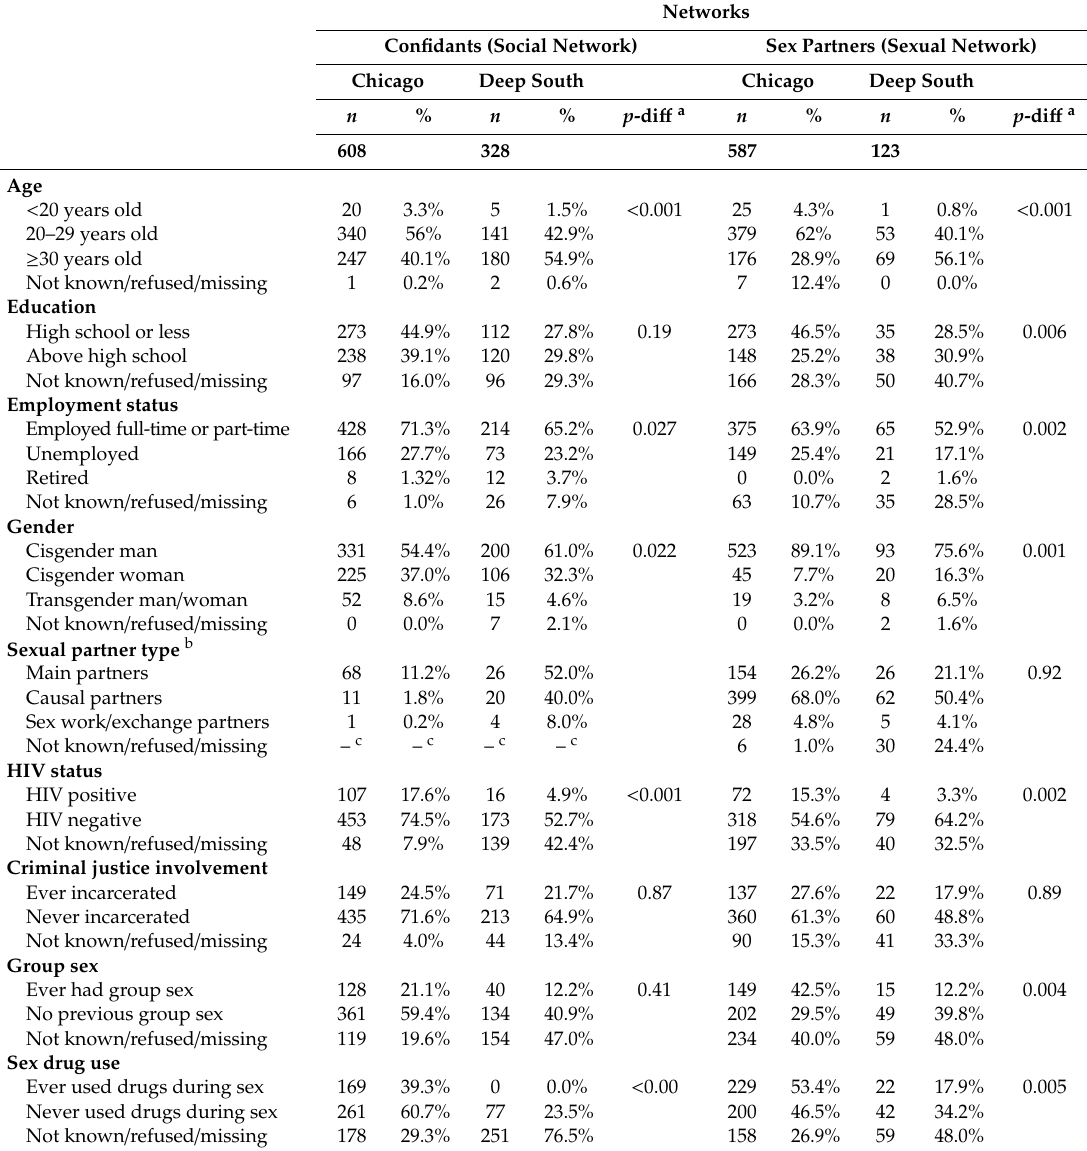
Table 5. Characteristics of sexual partners and social confidants at baseline among cisgender Black gay, bisexual, and other men who have sex with men participating in the Neighborhoods and Networks (N2) Cohort Study , enrolled as of 31 December